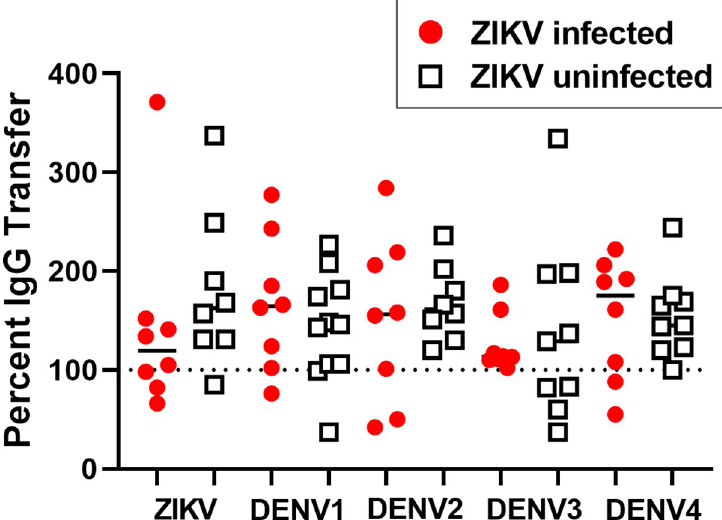
Fig 4. Efficient transplacental transfer of flavivirus-specific IgG. Plasma antibody binding to ZIKV, DENV1, DENV2, DENV3, and DENV4 was measured by virion capture ELISA using serial dilutions of maternal plasma and infant cord blood collected at delivery. The dilution at 50% of maximal binding (ED50) was calculated and the infant ED50 was assessed as a percentage of the maternal ED50 to yield percent transfer. Dotted line indicates 100% transfer and the solid line indicates the median. No significant differences in percent transfer were found in comparing ZIKV- infected and uninfected women for the all viruses tested by Exact Wilcoxon Rank Sum Test; Bonferroni adjusted P > 0.05 for all viruses